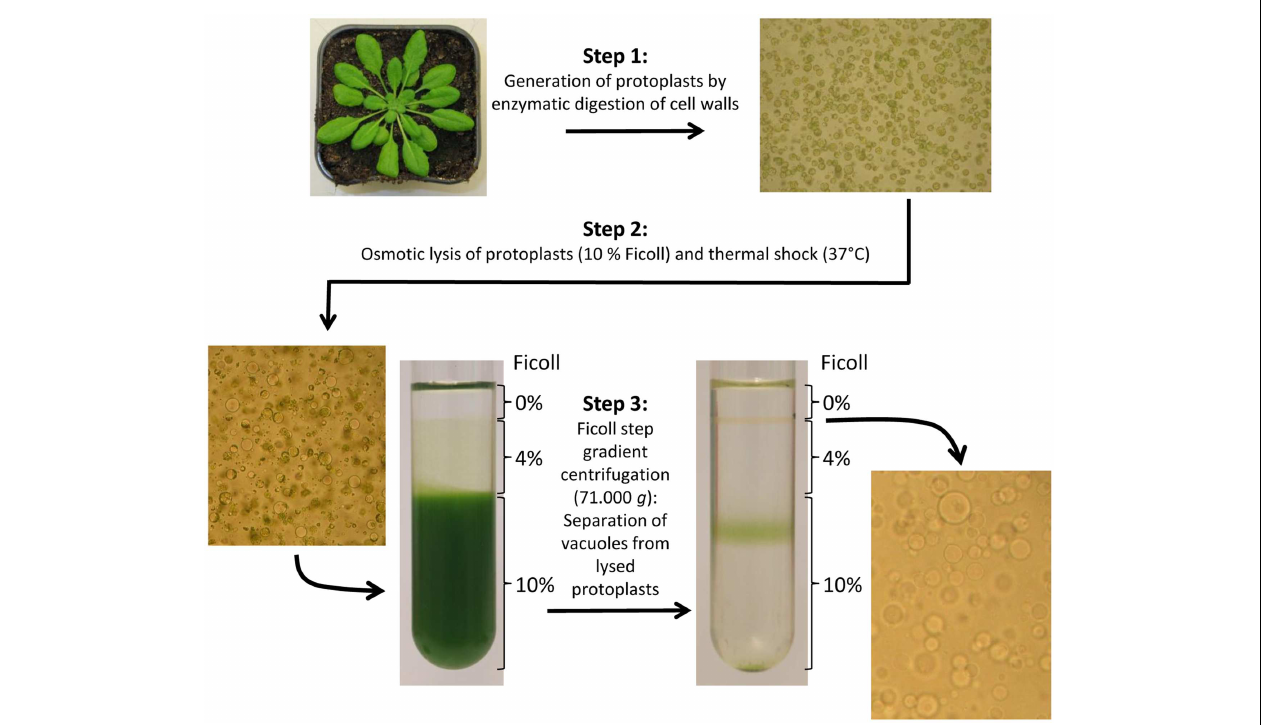
FIGURE 1 | Preparation of intact Arabidopsis thaliana vacuoles by generation of mesophyll cell protoplasts, osmotic/thermal lysis of protoplasts, and vacuole purification by use of a Ficoll step gradient (according to Robert et al., 2007). Microscopic pictures; 100-fold magnified.